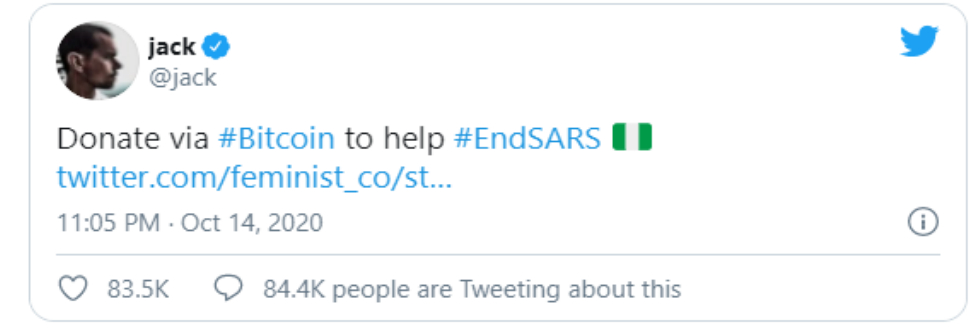
Figure 7: Twitter CEO endorses the #EndSARS protest; Source: Dorsey, 2020)